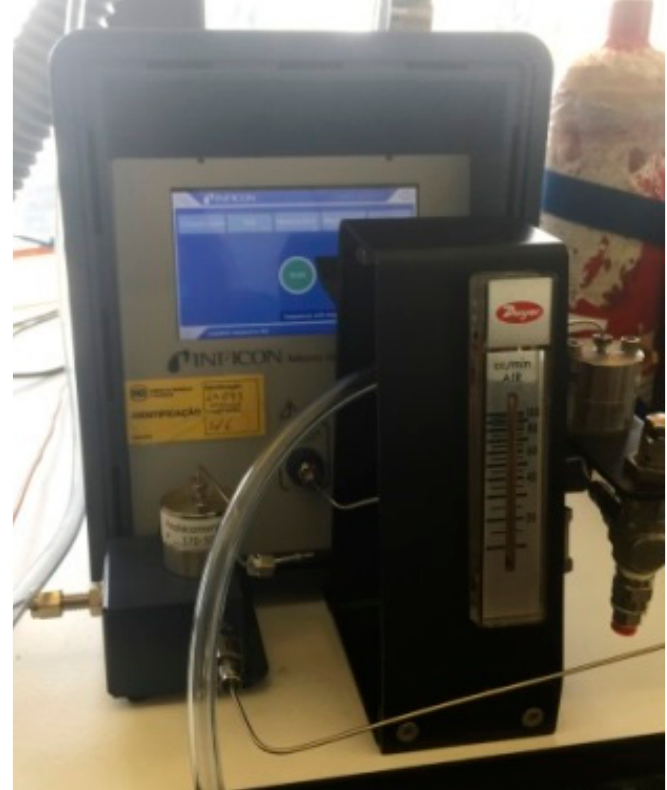
Figure 6. INFICON Micro GC Fusion. Table 2. Results of molar concentration in % of H 2 with 3% ( w/w ) of KOH.